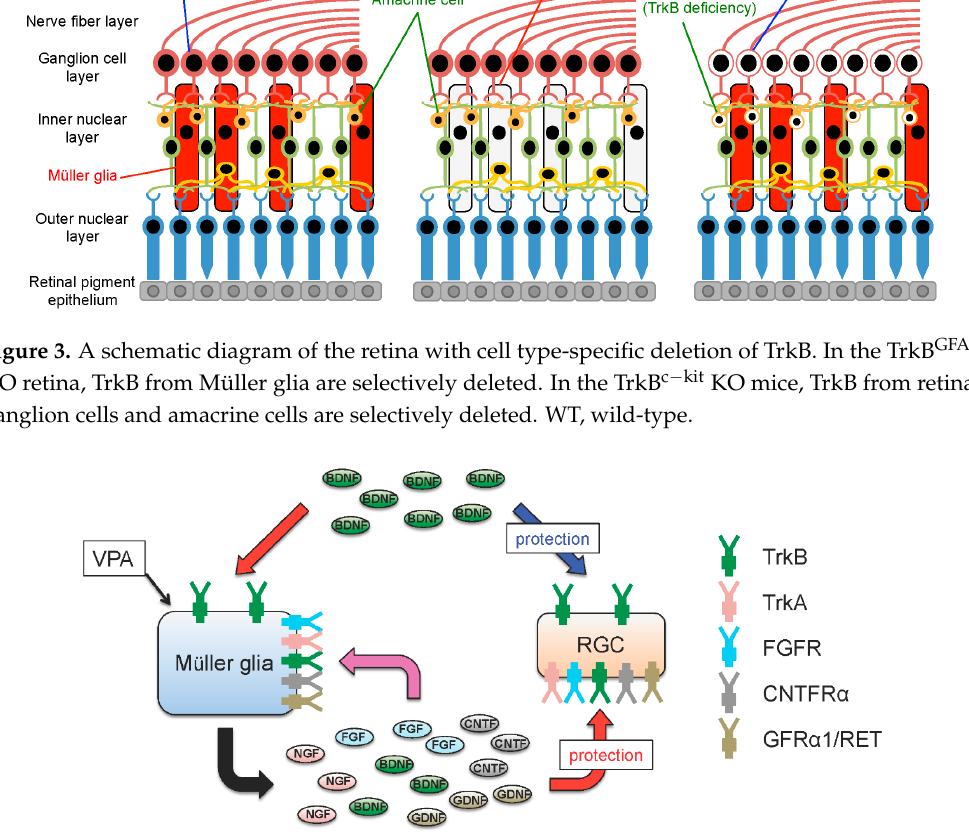
Figure 4. Neuroprotective effects of glial and neuronal TrkB signalling in the retina. BDNF exerts neuroprotective effects directly through TrkB expressed in retinal ganglion cells (RGCs) (blue arrow), and/or indirectly through TrkB expressed in Müller glia (red arrow). Stimulation of glial TrkB by BDNF upregulates various neurotrophic factors including BDNF, GDNF, FGF, CNTF and NGF (black arrows). These in turn increase neurotrophic factor production in an autocrine manner (pink arrow) and act on RGCs to promote survival in a paracrine manner (red arrow) [112,117]. In addition, stimulation of Müller glia by valproic acid (VPA) upregulates BDNF and NGF, which act on RGCs leading to neuroprotection.